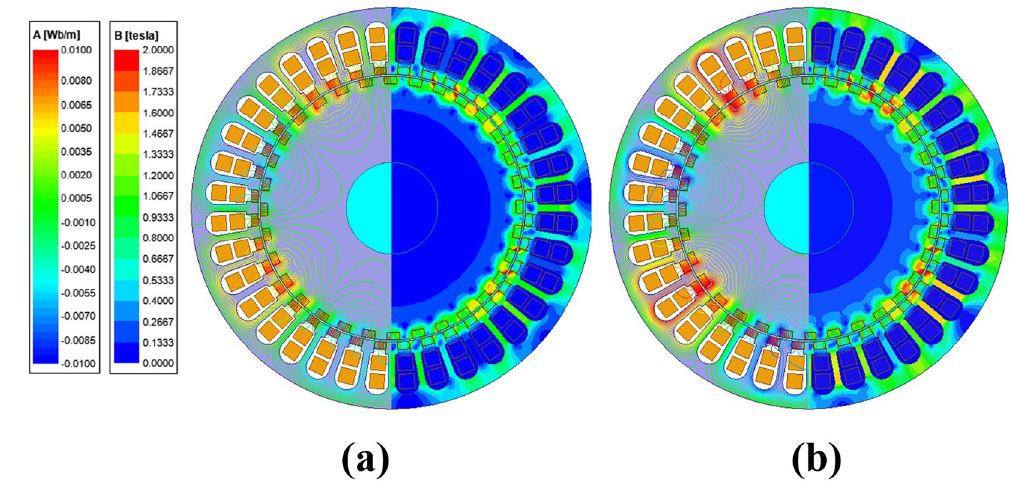
Figure 9. Flux density cloud map and flux line distribution. ( a ) 5 A/mm 2 , ( b ) 10 A/mm 2 .